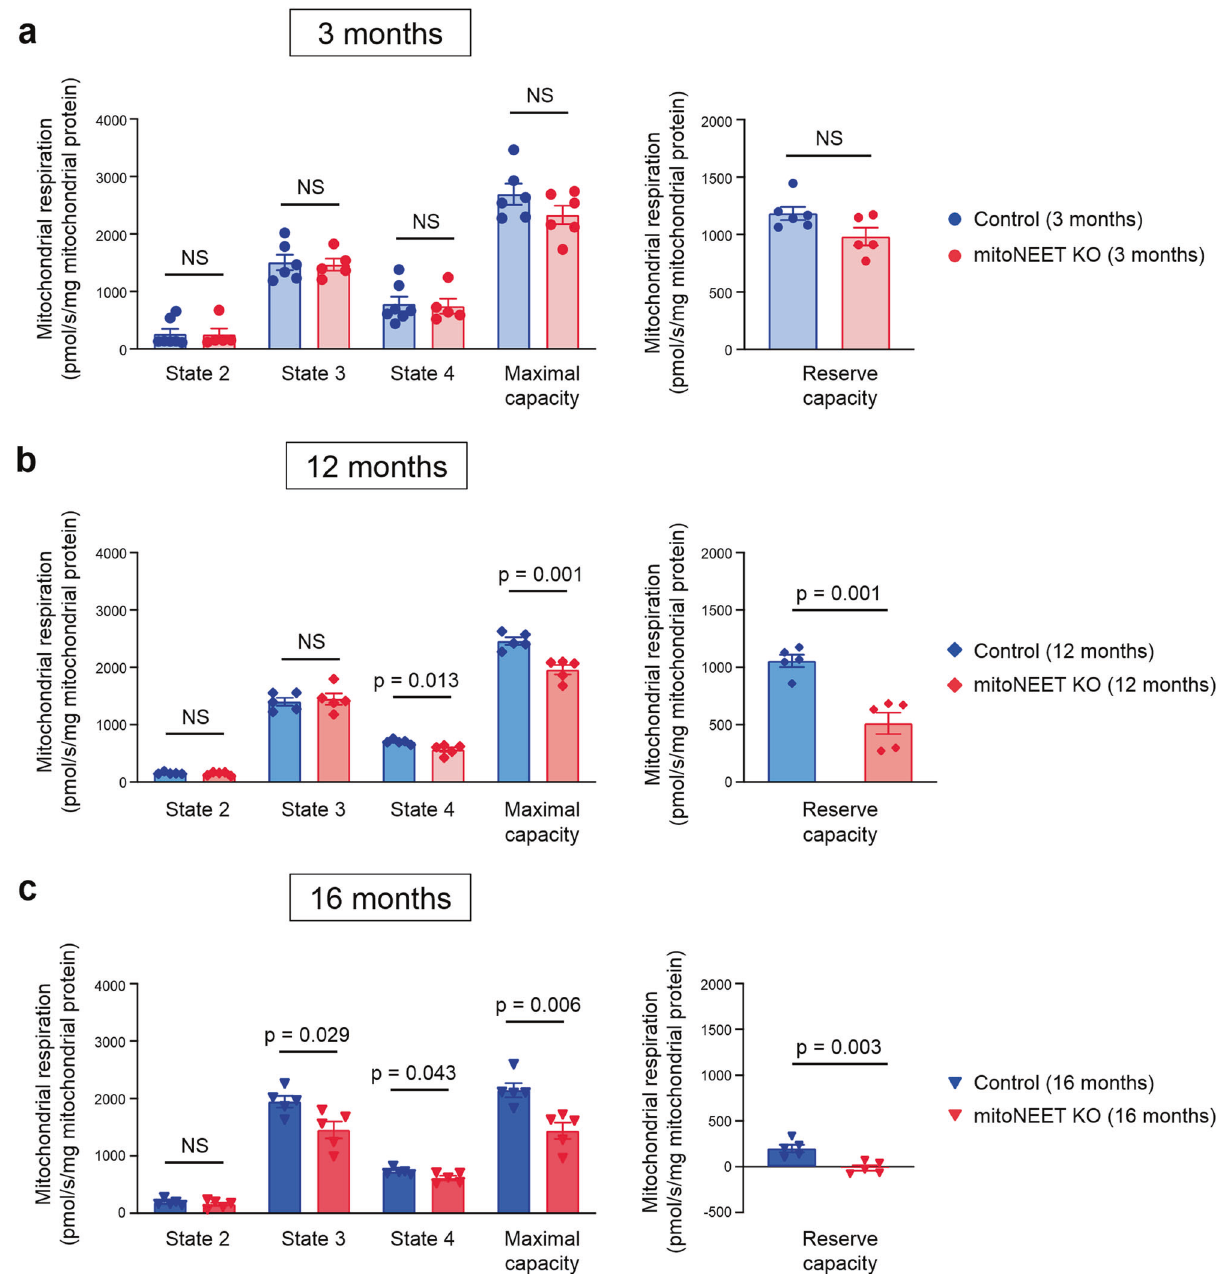
Fig. 3 Cardiac mitochondrial respiratory activities are impaired in mitoNEET KO mice older than 12 months. Mitochondrial respiration in isolated mitochondria during state 2, state 3, state 4, maximal capacity, and reserve capacity of control and mitoNEET KO mice at 3 months ( a ; n = 6 each), 12 months ( b ; n = 5 each), and 16 months of age ( c ; n = 5 each). Data are shown as the mean ± s.e.; individual data points are shown. The Student unpaired two-tailed t -test was performed to compare means between Control and mitoNEET KO mice of identical age. NS, not signi fi